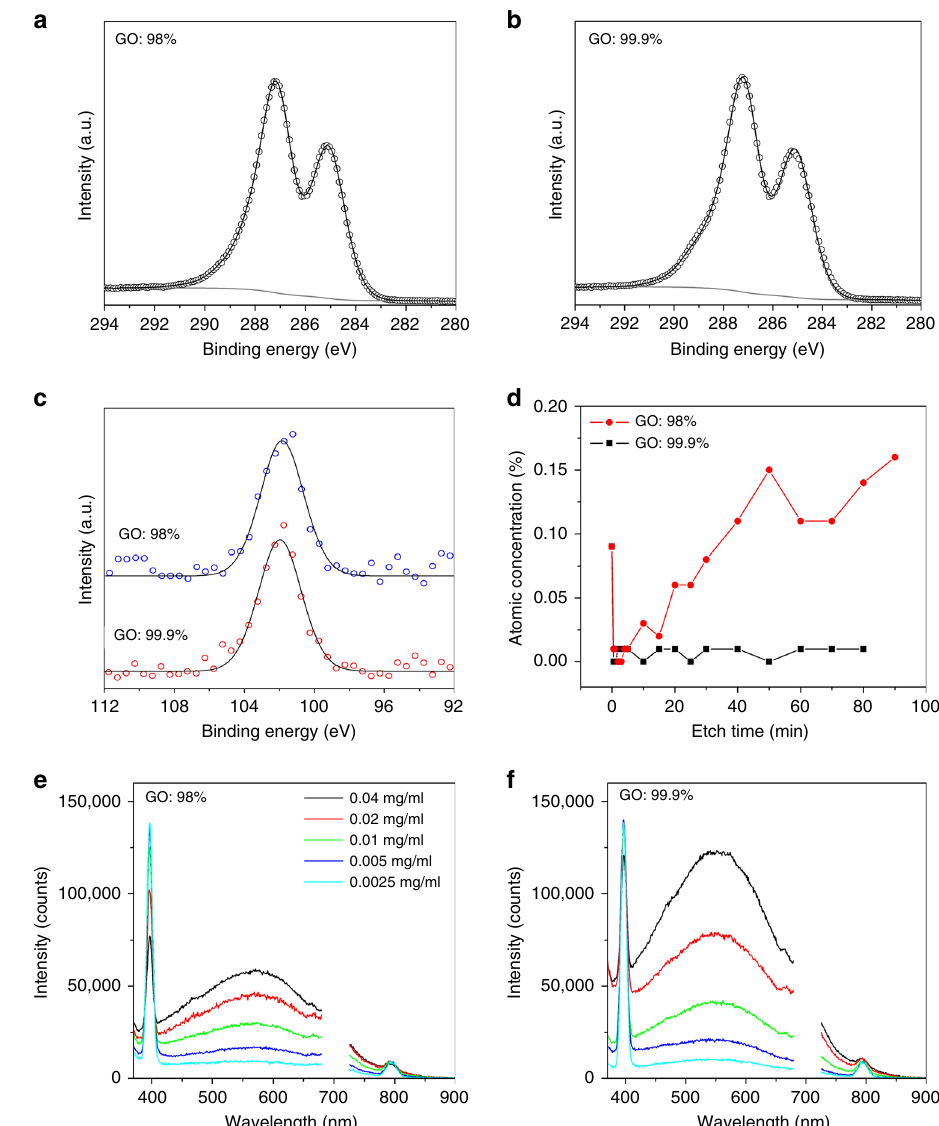
Fig. 7 Characterisation of typical GO fi lms and dispersions prepared from graphite feedstock of different purities. a , b Comparison of the XPS C 1s spectral region of GO fi lms. c Comparison of the XPS Si 2p spectral region of GO fi lms. d Comparison of the atomic concentration of silicon as a function of etching time. e , f Comparison of photoluminescence spectra ( λ exc = 350 nm) of GO dispersions in water as a function of solution concentration. The observed sharp peaks at 396 and 792 nm are due to the Raman peaks of water. The second-order diffraction peak at 700 nm has been removed for